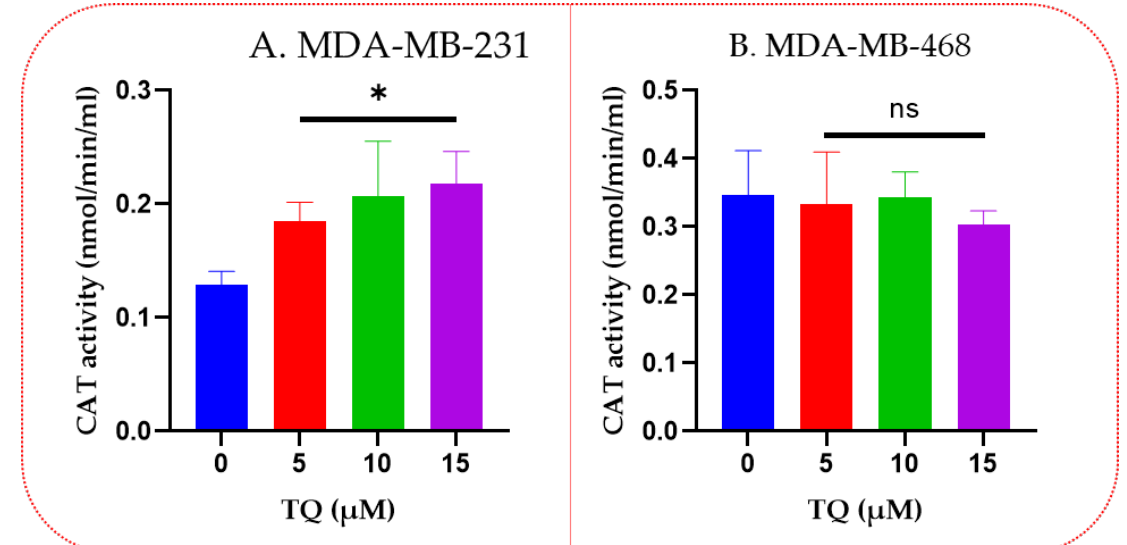
Figure 4. TQ impact on catalase enzyme activity in TNBC cells. 1.5 × 10 6 cells/well/6-well plate was incubated overnight, then treated for 24 h with TQ at various concentrations (0–15 µM). Catalase activity was displayed on MDA-MB-231 TNBC cells ( A ) and MDA-MB-468 TNBC cells ( B ). Asterisks show that catalase activity has significantly increased when compared to controls. Each bar indicates the mean ± SEM of three replications using a one-way ANOVA. * p < 0.05 is statistical significance, and ns: nonsignificant.